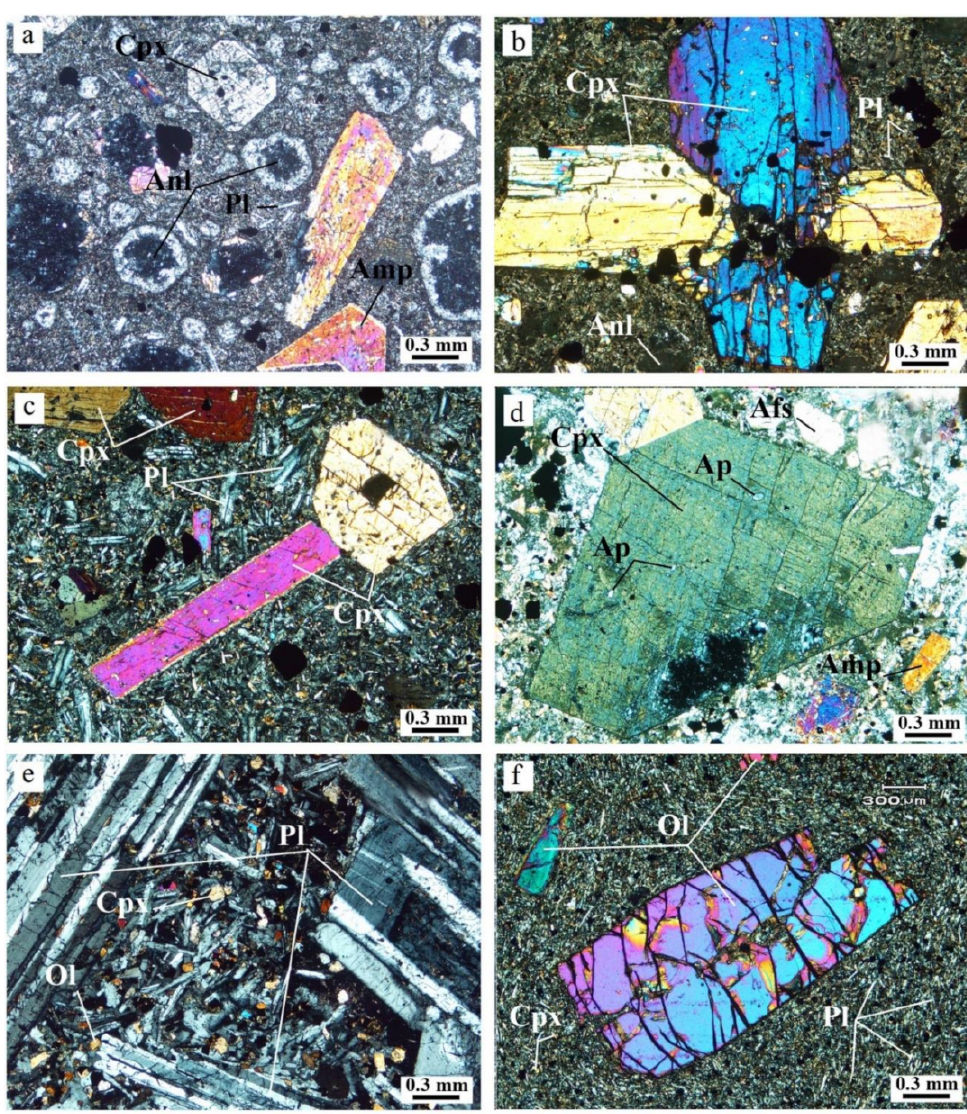
Figure 4. Photomicrographs in crossed polarized light of dyke rocks. ( a ) Analcime, plagio- clase and amphibole in tephrite. ( b ) Sector-zoned clinopyroxene, plagioclase and analcime in tephrite. ( c ) Clinopyroxene and plagioclase phenocrysts in pyroxene andesite with porphyric tex- ture. ( d ) Euhedral clinopyroxene with apatite inclusions and subhedral amphiboles in pyroxene andesites. ( e ) Plagioclase phenocrysts, clinopyroxene and olivine with seriate texture in andesite basalt. ( f ) Olivine phenocrysts and plagioclase in olivine basalt. Mineral abbreviations from [57]: Amp = amphibole, Pl = plagioclase, Cpx = clinopyroxene, Anl = analcime, AP= apatite, Afs = alkali feldspar and Ol =